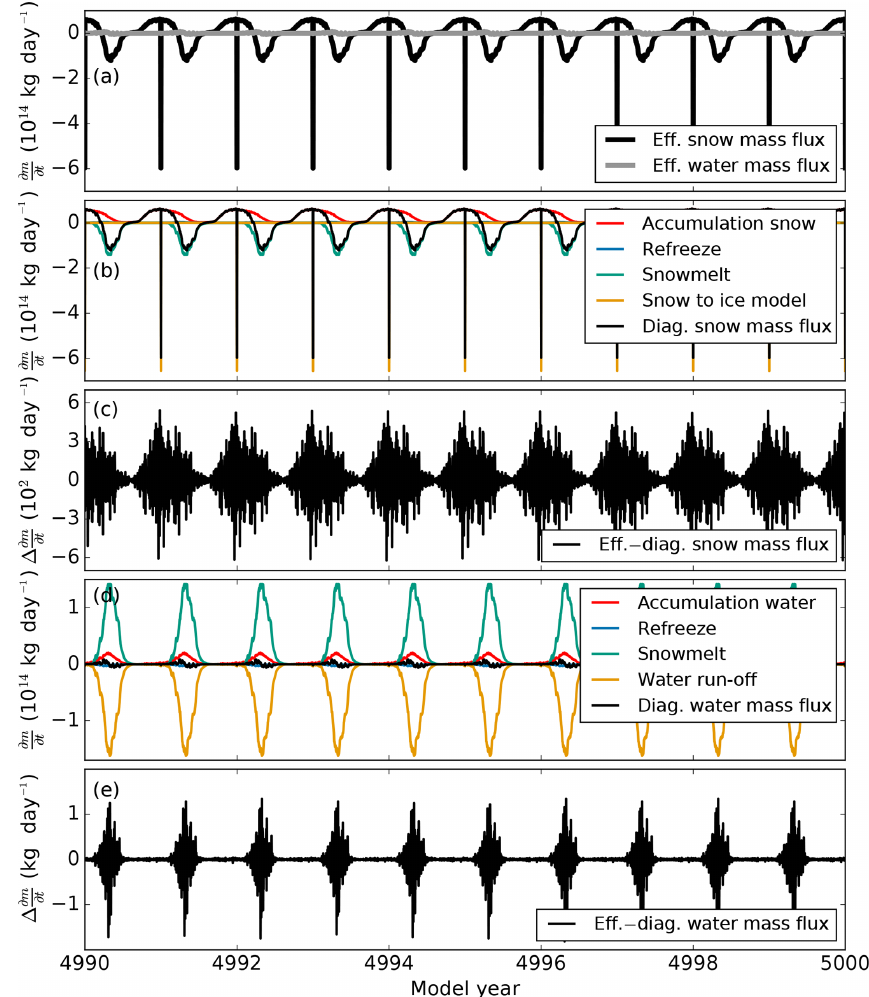
Figure 5. Total mass fluxes summed up over the entire model domain 5000 years after initialization. (a) Effective changes in snow and water mass inside the snow model. (b) Diagnosed fluxes in snow mass with all its contributing terms. (c) Effective minus diagnosed snow mass fluxes. (d) Diagnosed fluxes in water mass with all its contributing terms. (e) Effective minus diagnosed water mass